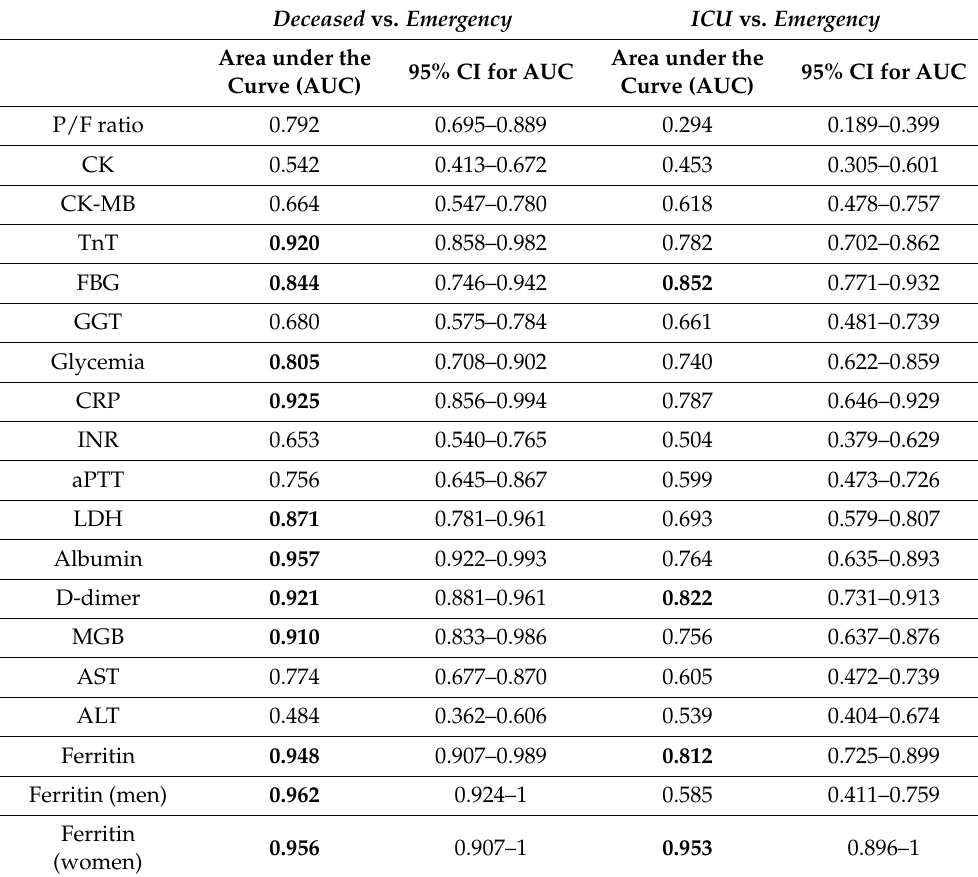
Table 5. AUC scores for the P/F ratio. CK, CK-MB, TNT, FBG, GGT, glycemia, CRP, INR, aPTT, LDH, albumin, D-dimer, MGB, AST, ALT, and ferritin (men and women—see Section 2). The highest scores (in bold) were disclosed for TNT, FBG, glycemia, CRP, and LDH, albumin, D-dimer, MGB, and ferritin in the deceased group, but only for FBG, D-dimer, and ferritin in the ICU group. Significant scores are shown in bold. Deceased vs. Emergency ICU vs. Emergency Area under the Area under the 95% CI for AUC 95% CI for AUC Curve (AUC) Curve (AUC) P/F ratio 0.792 0.695–0.889